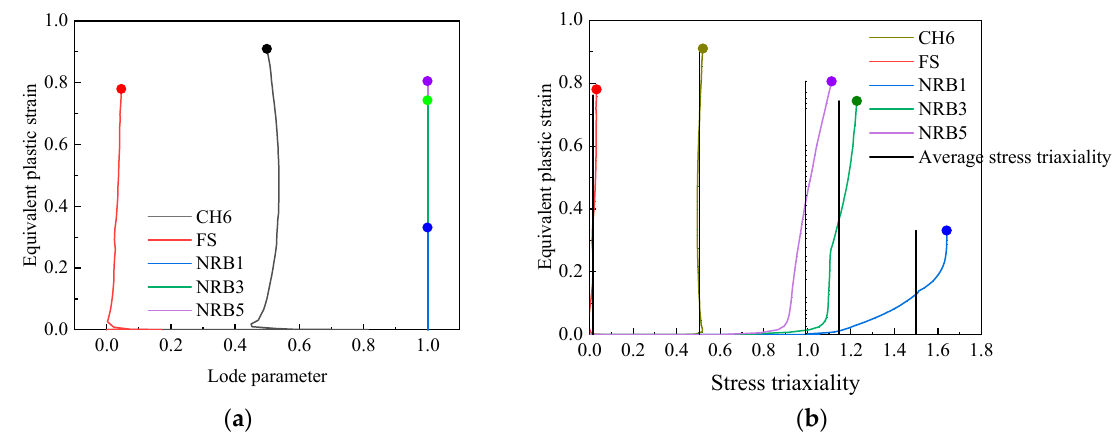
Figure 11. Evolution of equivalent plastic strain and stress states: ( a ) evolution of equivalent plastic strain and Lode parameters; and ( b ) evolution of equivalent plastic strain and stress triaxiality.